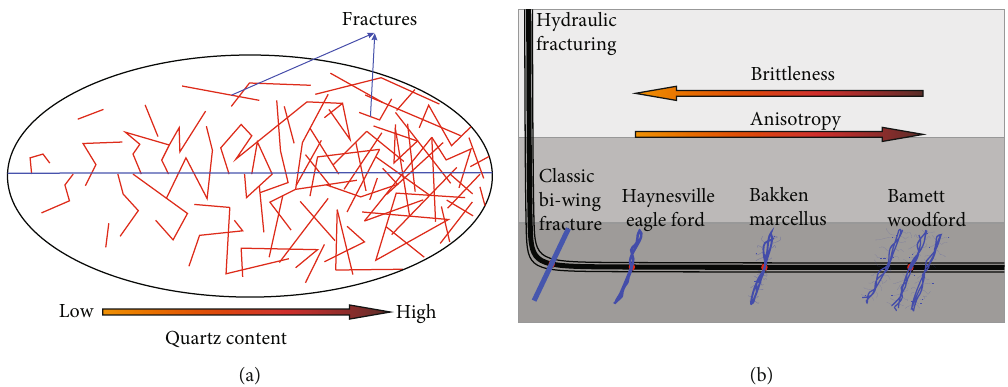
Figure 16: Schematic diagram of quartz content and fracture density: (a) the relationship between quartz content and fracture density and (b) the correlation between shale gas reservoir properties and hydraulic fracturing. Table 5: Fractal dimension values of stress levels under di ff erent quartz contents. Stress